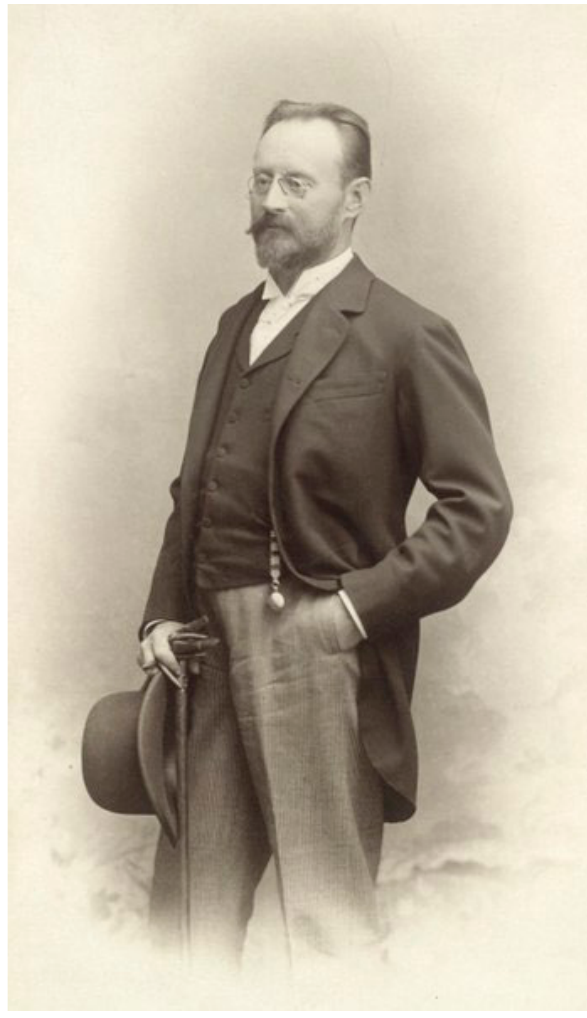
Figure 5. Carl Auer von Welsbach. Source: https://commons.wiki-